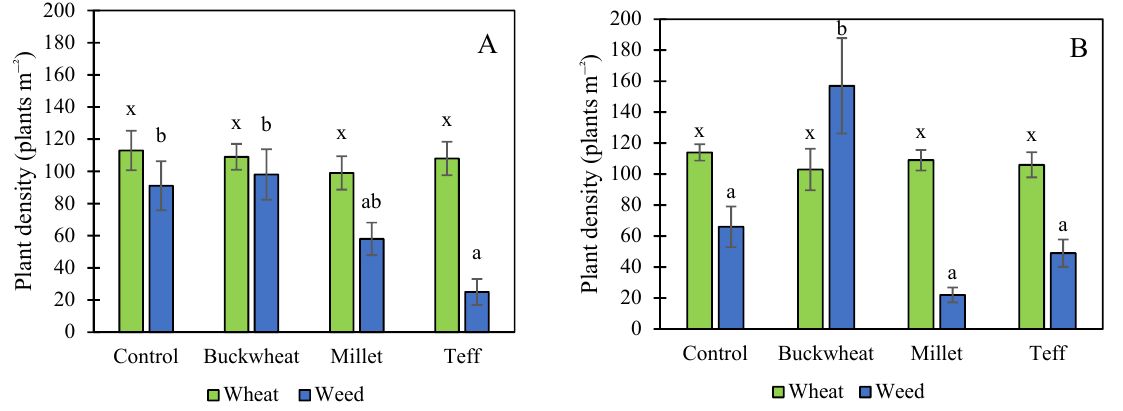
Figure 4. Density of wheat and weed plants at Bringelly ( A ) and Lansdowne ( B ). Error bars show standard error. Different letters show significant differences ( p < 0.05) (ab for weed density and x for wheat density).